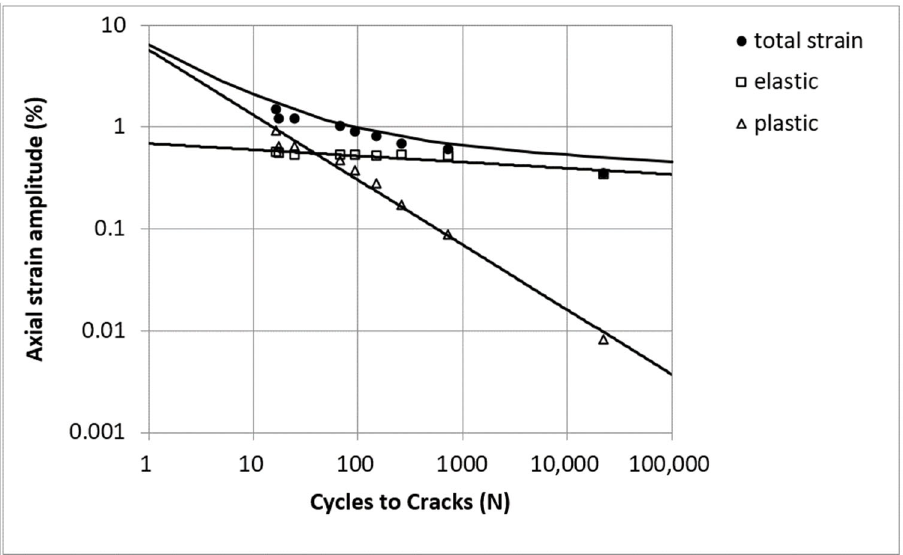
Figure 7. Axial strain life diagram for AlMgSi1.